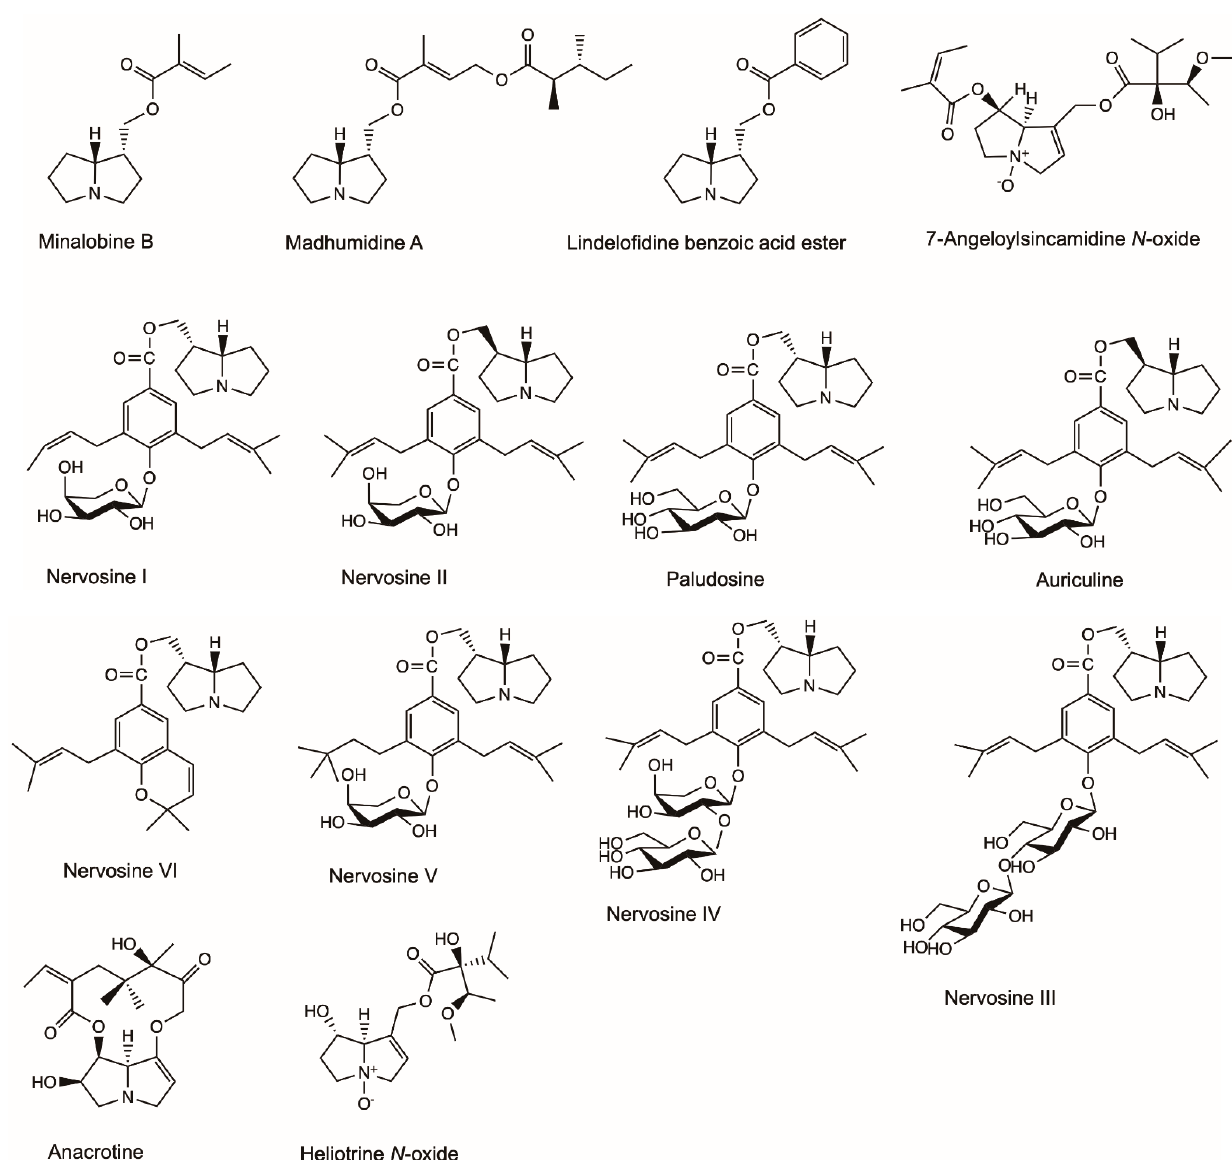
Figure 4. Effective chemical structures of pyrrolizidine alkaloids with anti-inflammatory activities in this review. Oedema is an excess of fluid in the tissues and is a symptom of disease [49]. Ghosh and Singh [50] investigated the anti-inflammatory activity of anacrotine isolated from Crotalaria laburnifolia Linn in rats (Figure 4). Anacrotine (40 mg/kg s.c. * 5 alternate days) had no significant inhibitory effect against formalin-induced arthritis, while it showed inhibition against carrageenin-induced oedema. In normal or adrenalectomized rats, anacrotine (10 mg/kg s.c.) inhibited hyaluronidase-induced oedema. Anacrotine (40 mg/kg s.c. and 30 mg/kg i.p., respectively) was ineffective against 5-hydroxytryptamine- and